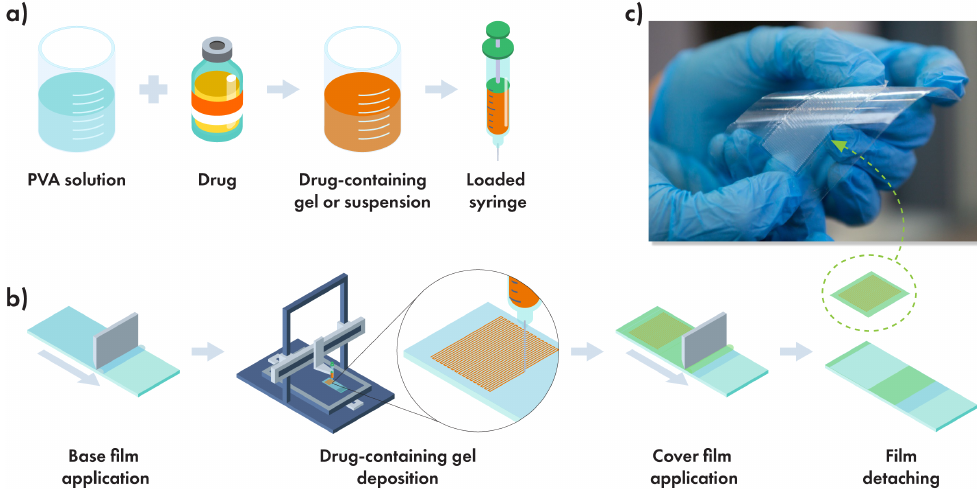
Figure 1. The design of the PLACE approach. ( a ) Mixing of the drug-containing matrix, ( b ) film fabrication pathway, and freestanding ready-to-use film ( c